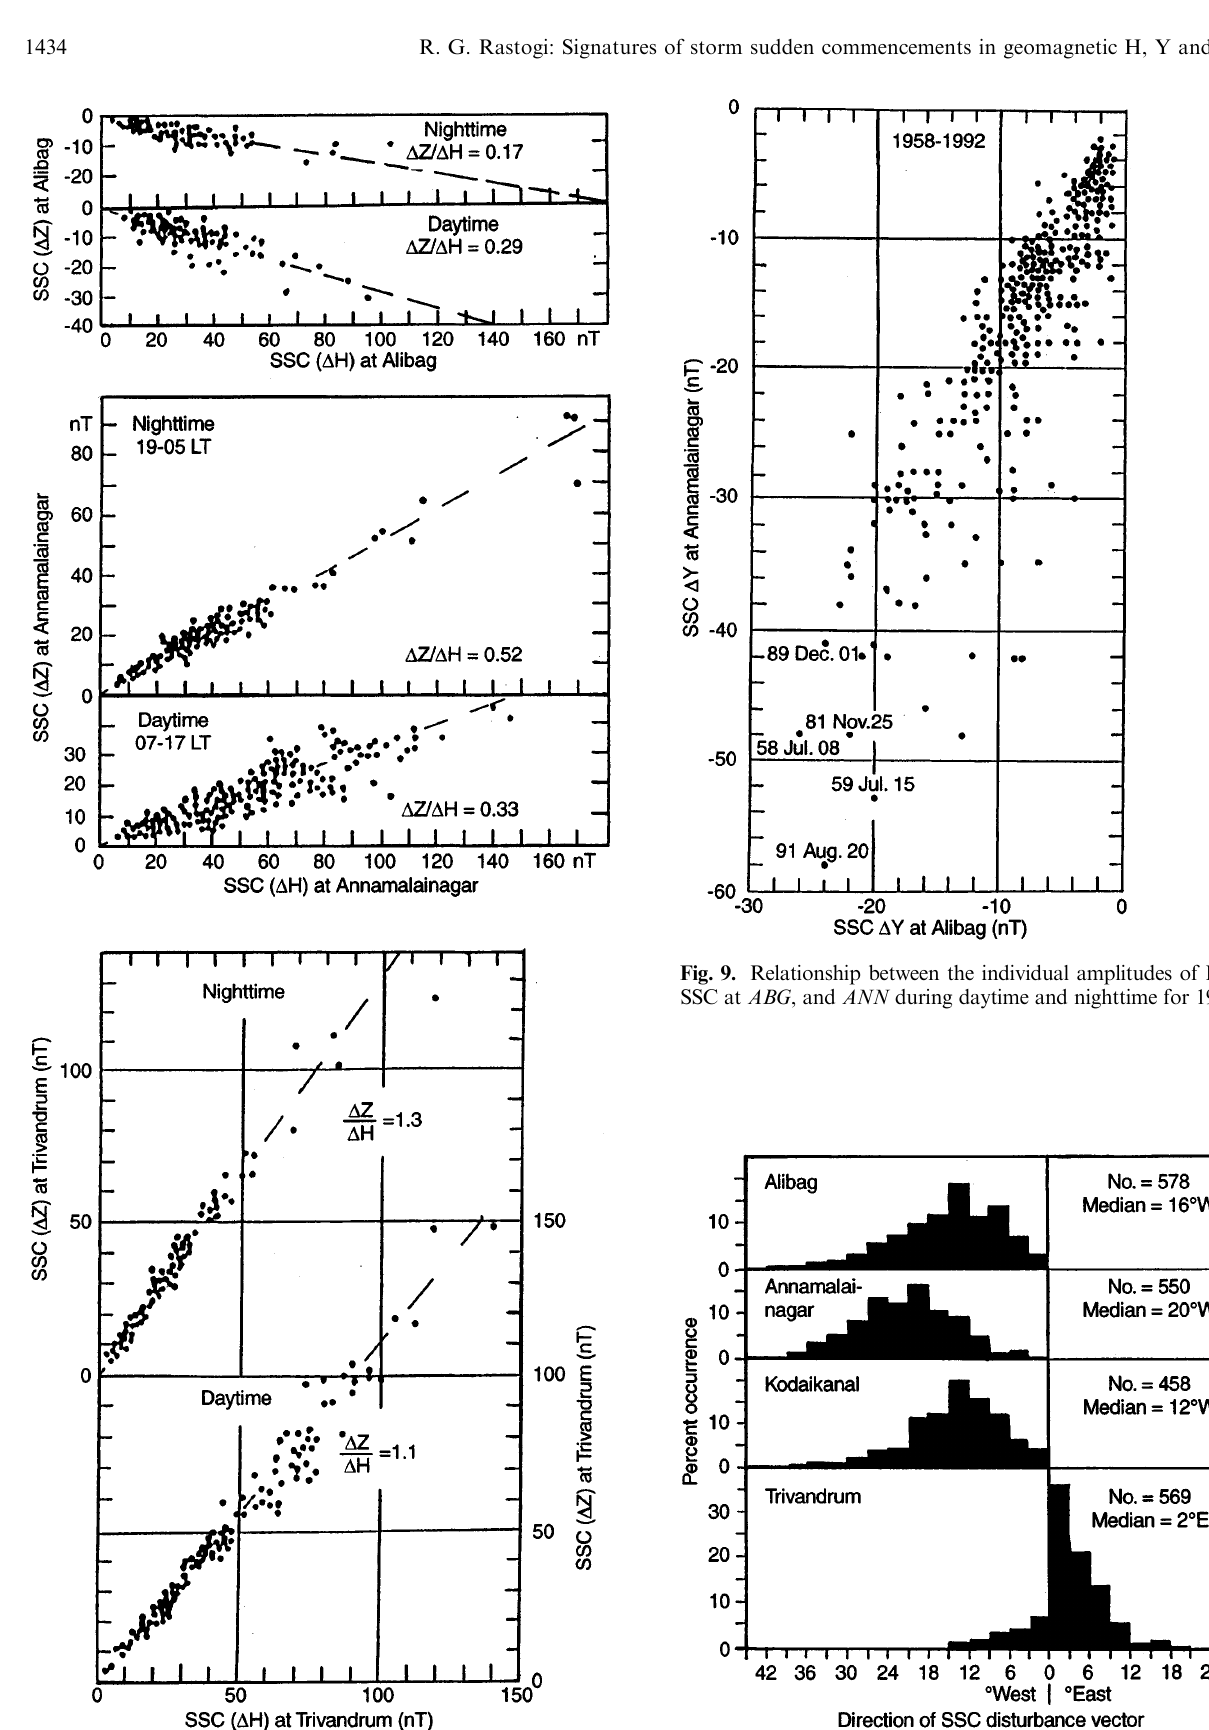
Fig. 8. Relationship between the individual amplitudes of D Z and D H due to SSC during daytime and nighttime for TRD , ANN and ABG for 1958–1992